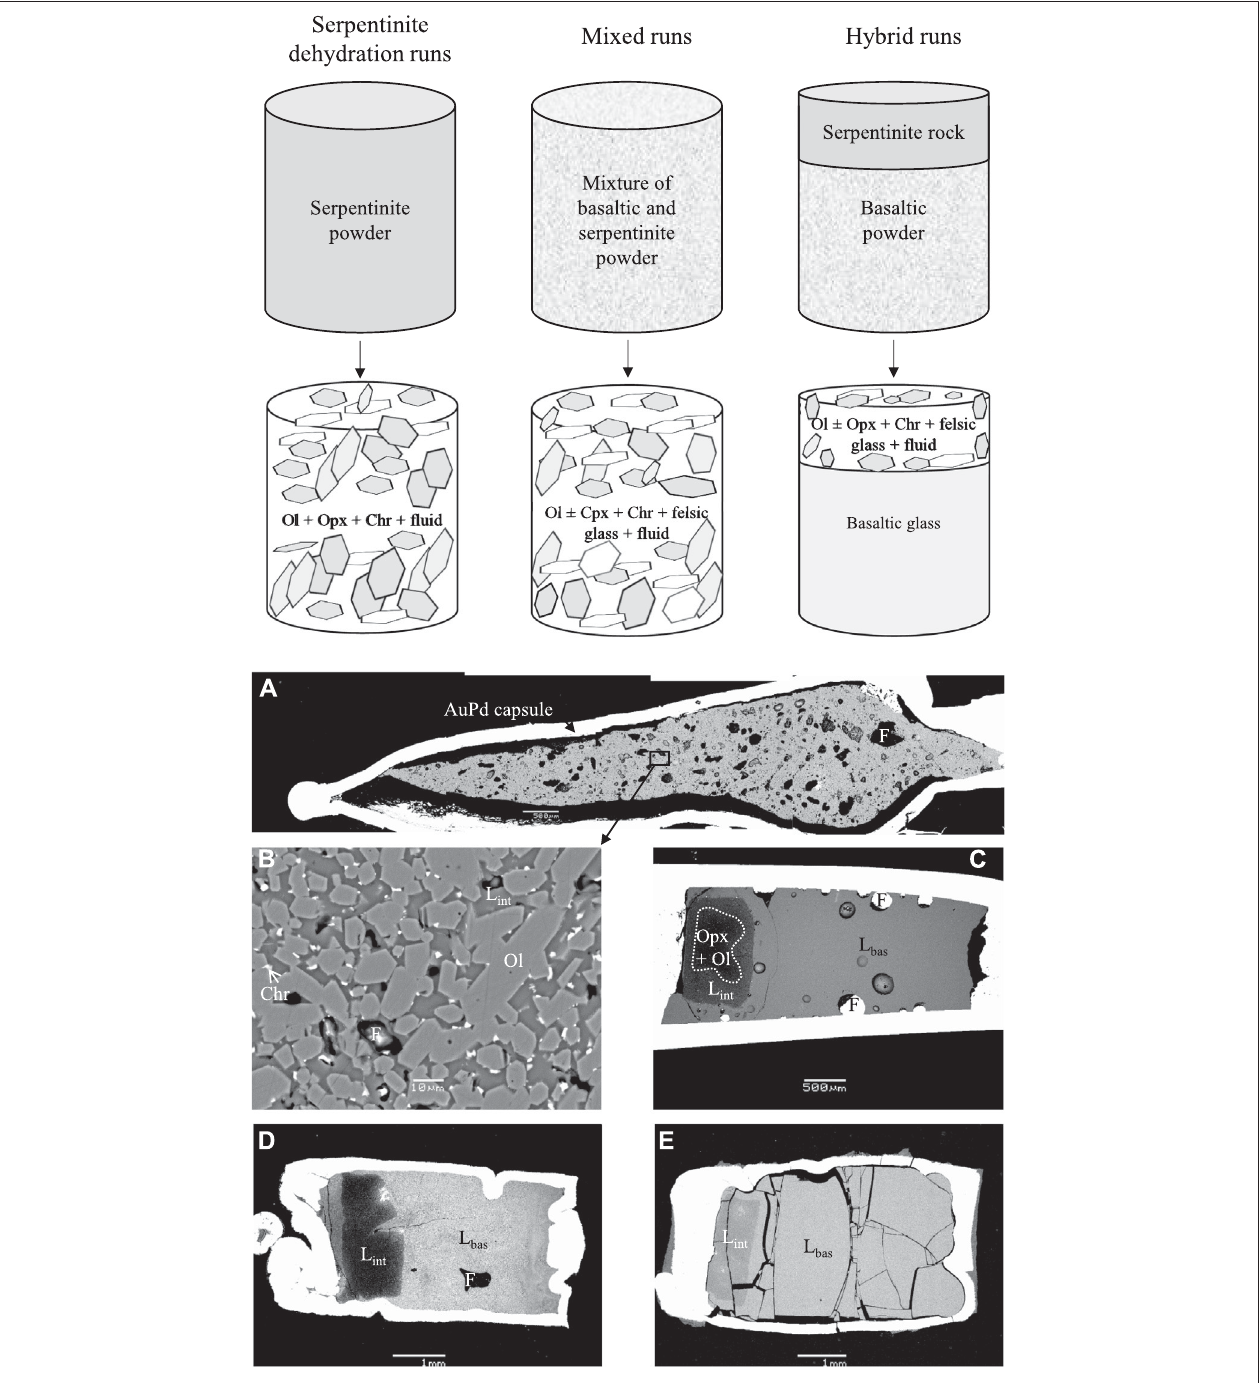
FIGURE 1 | Upper panel: Scheme of time-series runs at 0.2 GPa, showing starting con fi gurations and fi nal products containing felsic glasses. Three types of experiment are described: serpentinite dehydration, and mixed and hybrid runs. Ol, high-Mg olivine; Opx, orthopyroxene; Cpx, clinopyroxene; Chr, chromite or chromiferousmagnetite;felsicglass,intermediatetofelsicglassesand fl uid,aqueous fl uid. Lowerpanel: Backscatteredelectronimagesofthehybridandmixedrunsat 0.2 – 1.0 GPapressures. (A) mixedrunSB7at0.2 GPa; (B) zoomontheSB7withmagni fi cationof1,100;hybridruns: (C) P32at0.2 GPa; (D) P1at0.5 GPa; (E) P3 at 1.0 GPa. Mixed samples (SB7) is homogeneous sample with high-Mg olivine and interstitial felsic glasses. Hybrid samples (P32, P1, and P3) contain two zones: olivine-rich zone (the former serpentinite zone) with interstitial felsic melt (L int ) and zone of reacting basalt (L bas ). Ol, high-Mg olivine; Opx, orthopyroxene; Chr, chromite, andF,aqueous fl uid.Itshouldbenotedthatthehomogeneousolivine-richzonecontaininghigh-Mgolivine,chromite,interstitialfelsicmelt,andaqueous fl uidisformedin the mixed run SB7 ( R (cid:1) 0.25) at an early stage (in less than 2 h), suggesting early attainment of steady state in this system with a high starting proportion of serpentinite (80 wt%). All details may be found in Table 1 and Supplementary Table S2 .